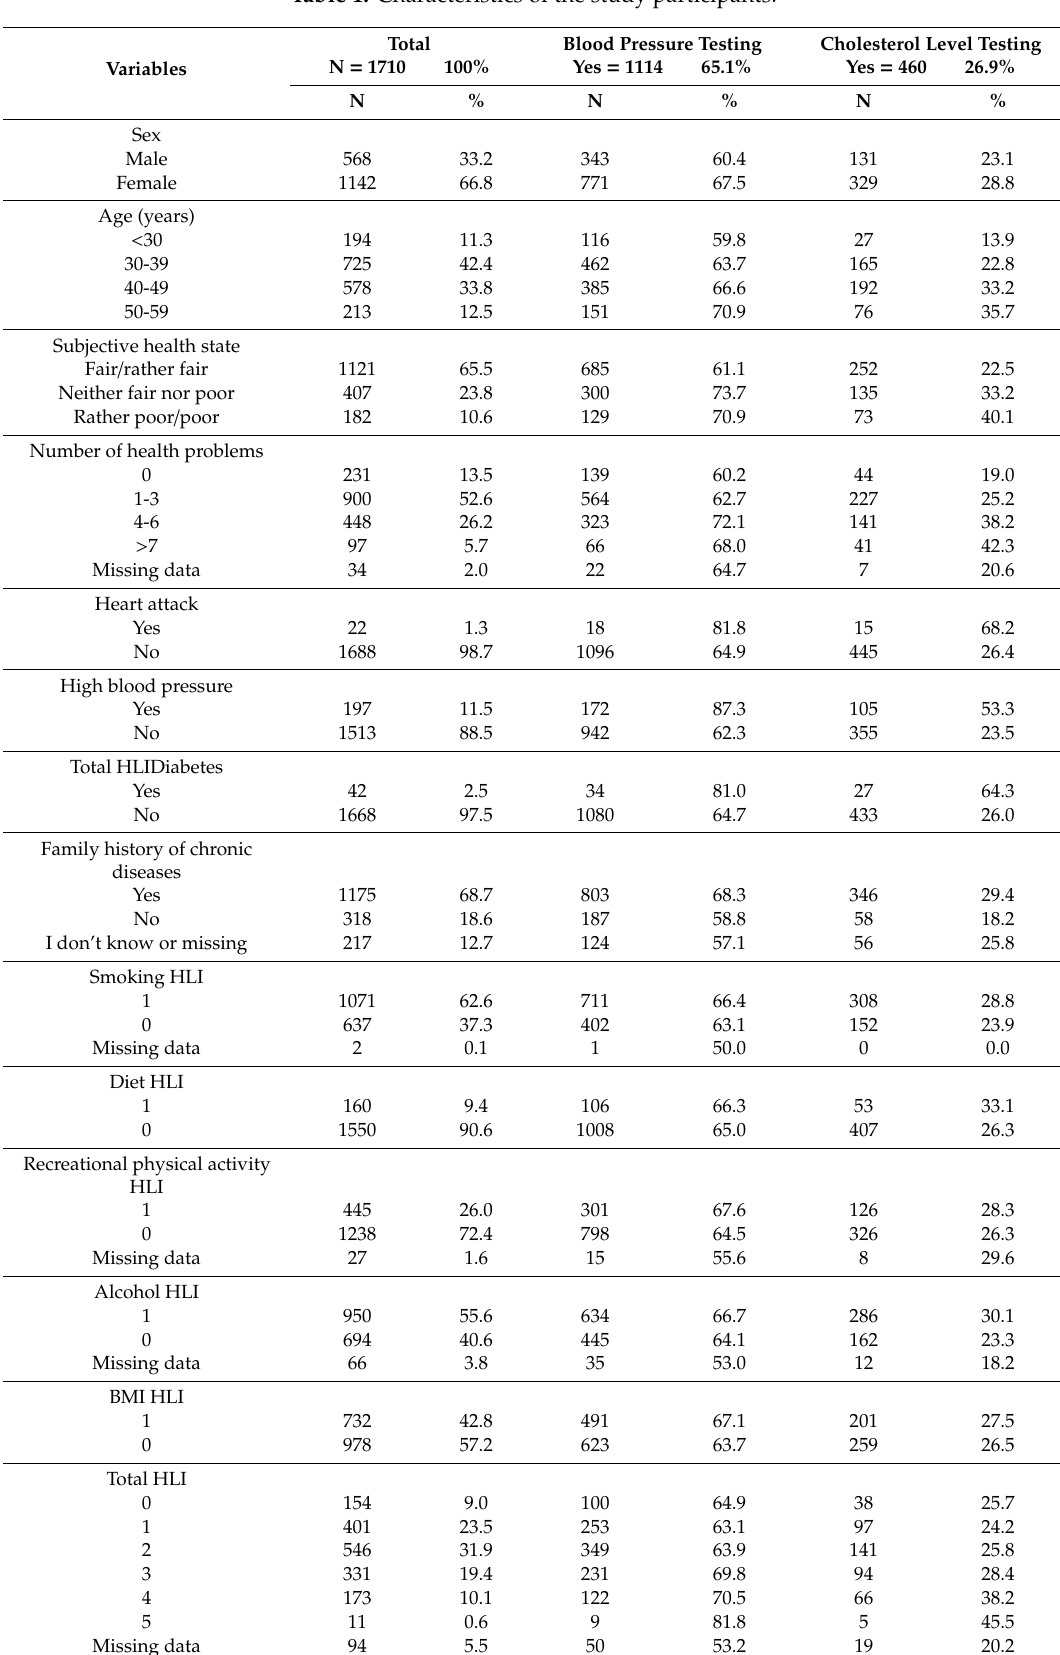
Table 1. Characteristics of the study